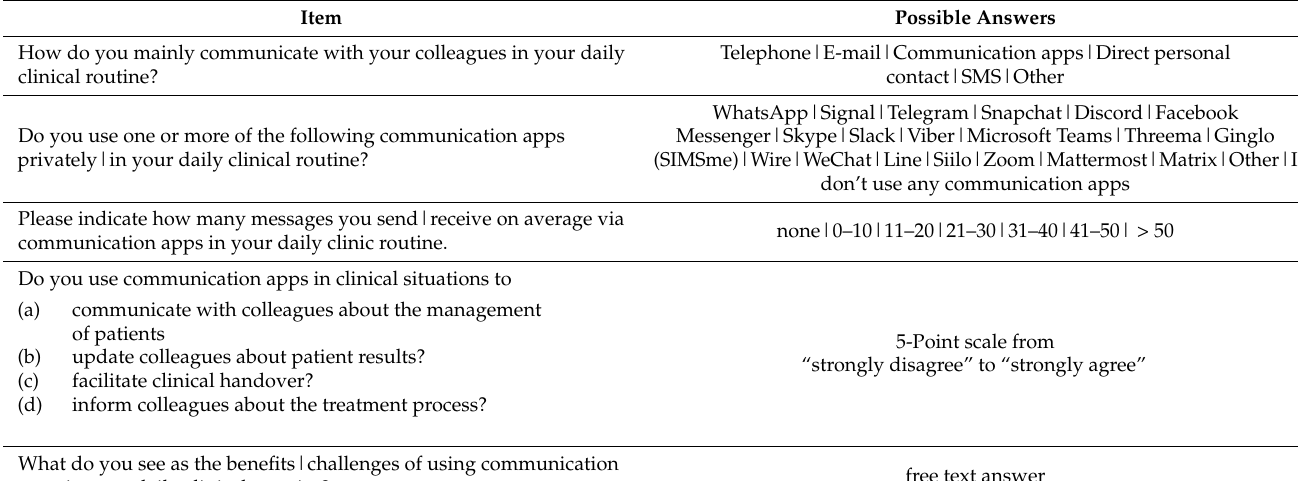
Table 1. Example questions and answer